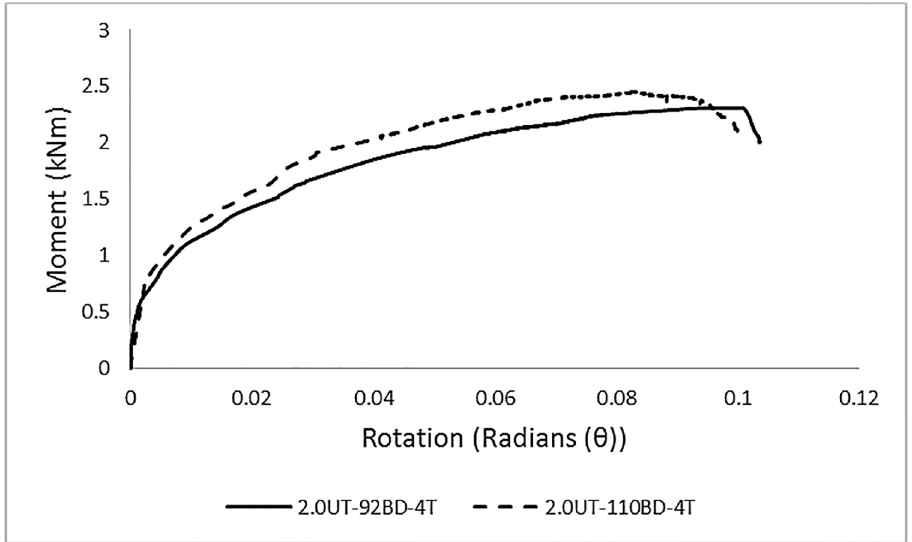
Fig 10. Effect of varying beam depth with constant column thickness and number of tabs in the beam end